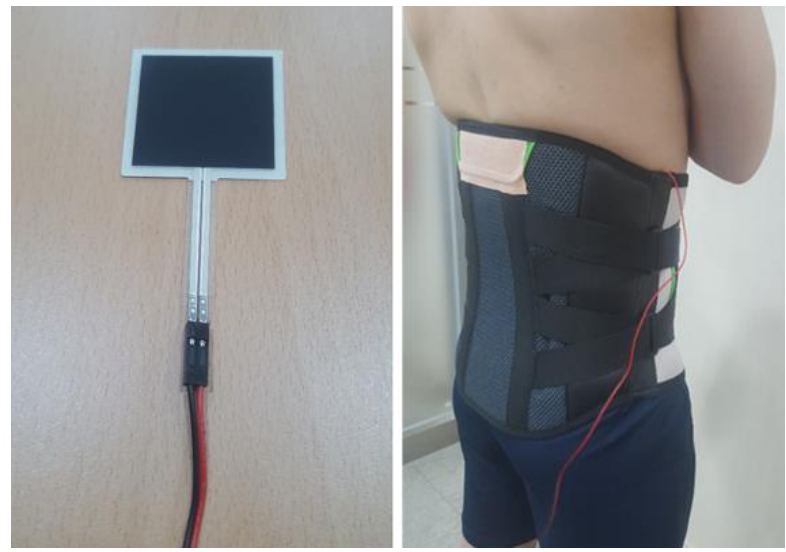
Figure 1. Measurement of the pressure of the lumbar belt using a force-sensing resistor.